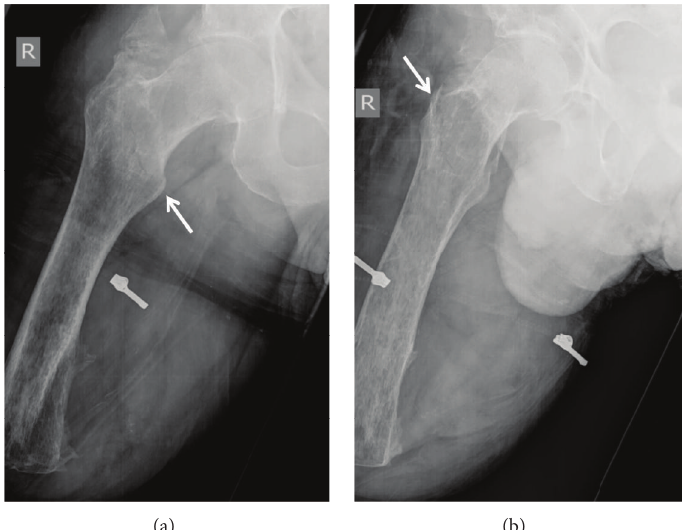
Figure 1: Anteroposterior and lateral radiographs of the right hip demonstrating an undisplaced extracapsular intertrochanteric fracture (white arrow).